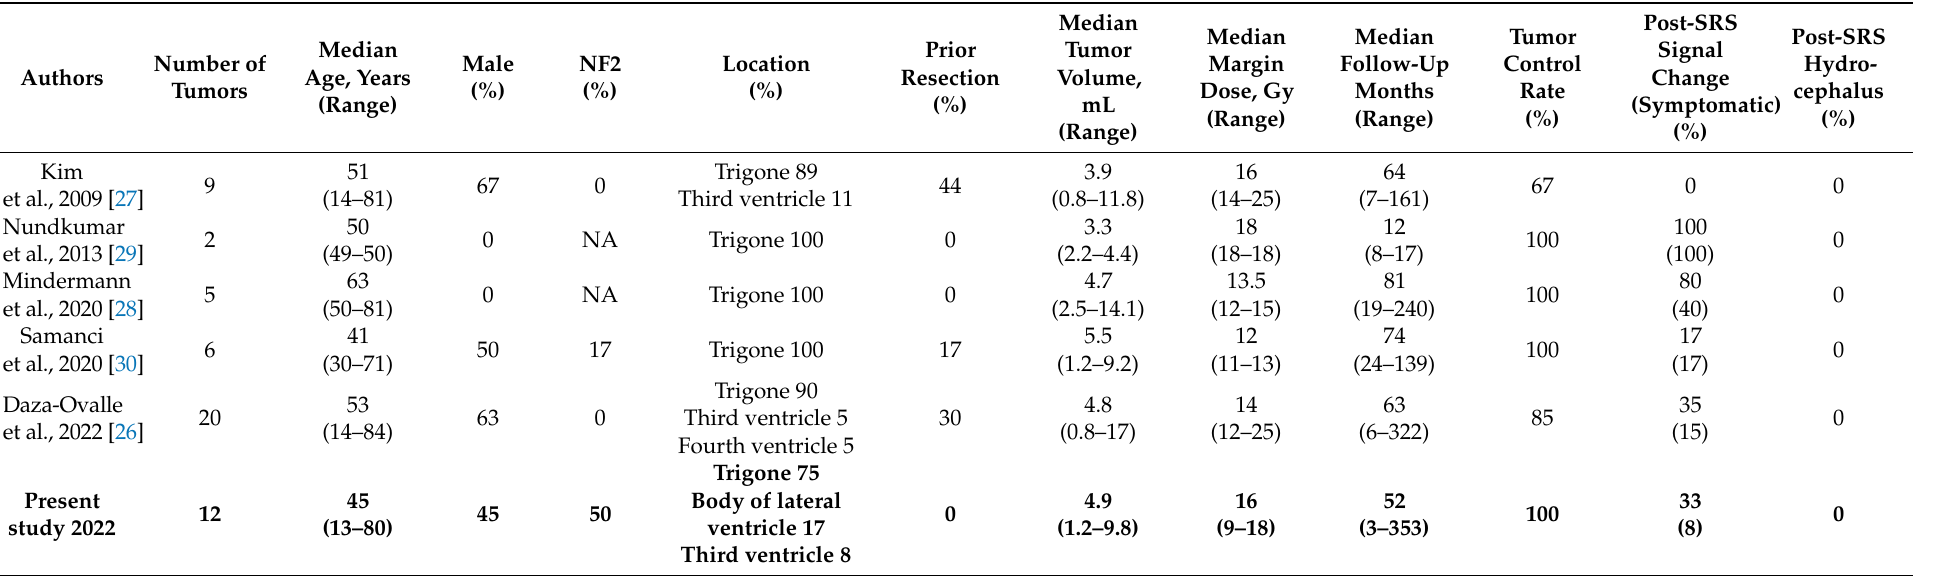
Table 4. Summary of previous studies of SRS for